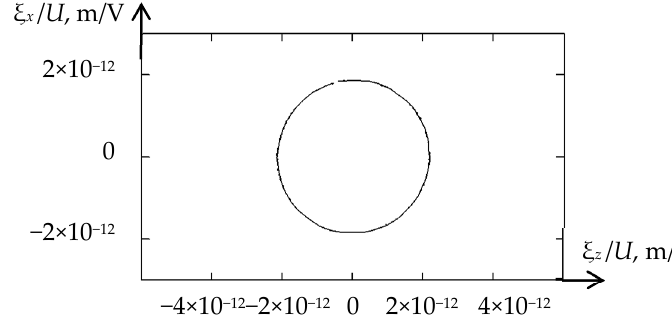
Figure 6. The trajectory of particle motion in radiated wave.